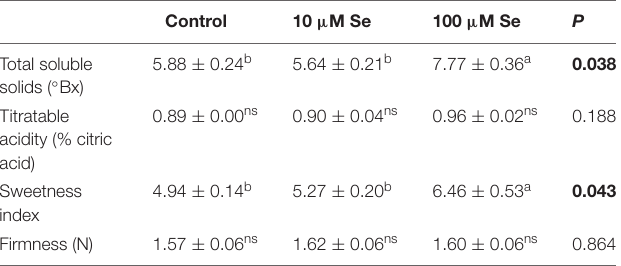
TABLE 3 | Total soluble solids ( ◦ Bx), titratable acidity expressed as % citric acids, sweetness index and firmness of strawberries grown in a full nutrient (control) and a nutrient solution either supplied with 10 or 100 µ M Se.